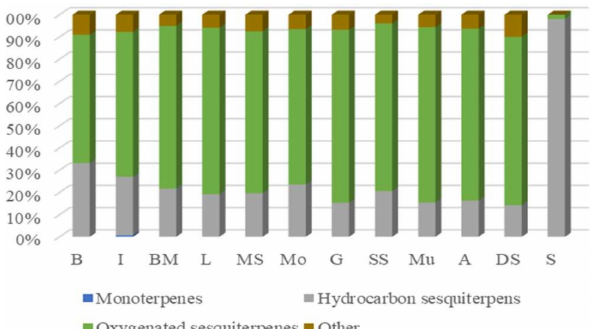
Figure 1. Volatile oil components from Matricaria chamomilla populations as a percentage of total identified